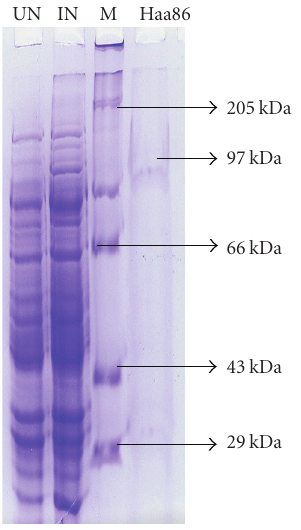
Figure 2: The SDS-PAGE profile of rHaa86. Legends: UN- uninduced, IN induced, M-molecular weight marker, Haa86- 97kDa expressed